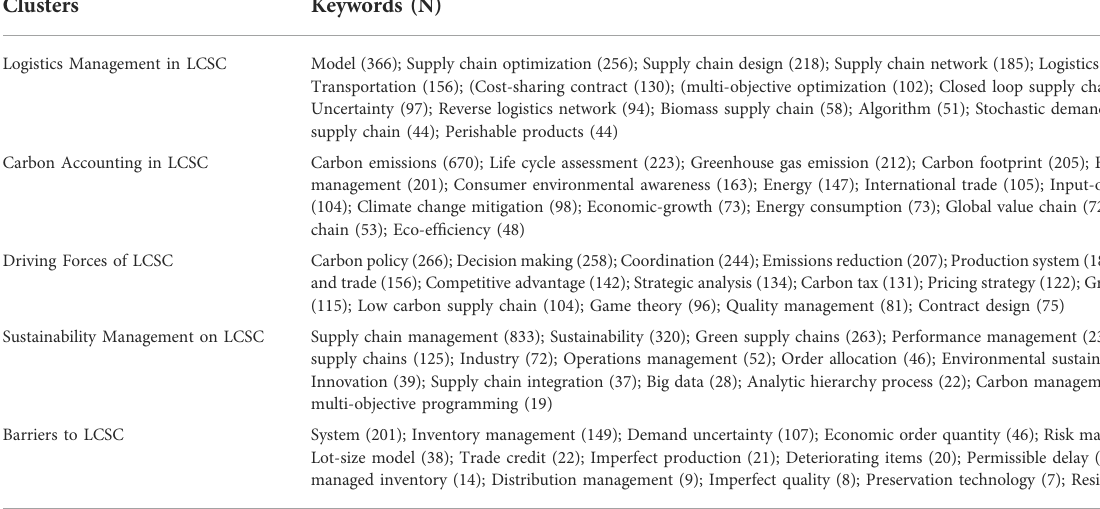
TABLE 6 Top 15 keywords and their frequency in each